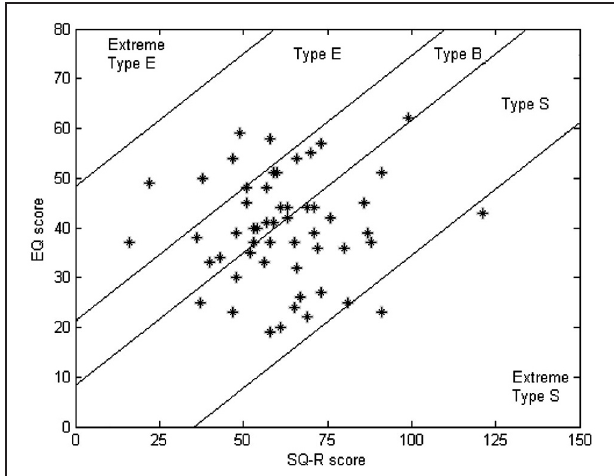
FIGURE 1 | The EQ and SQ-R scores of the participants with the boundaries of different types according to Wheelwright et al.